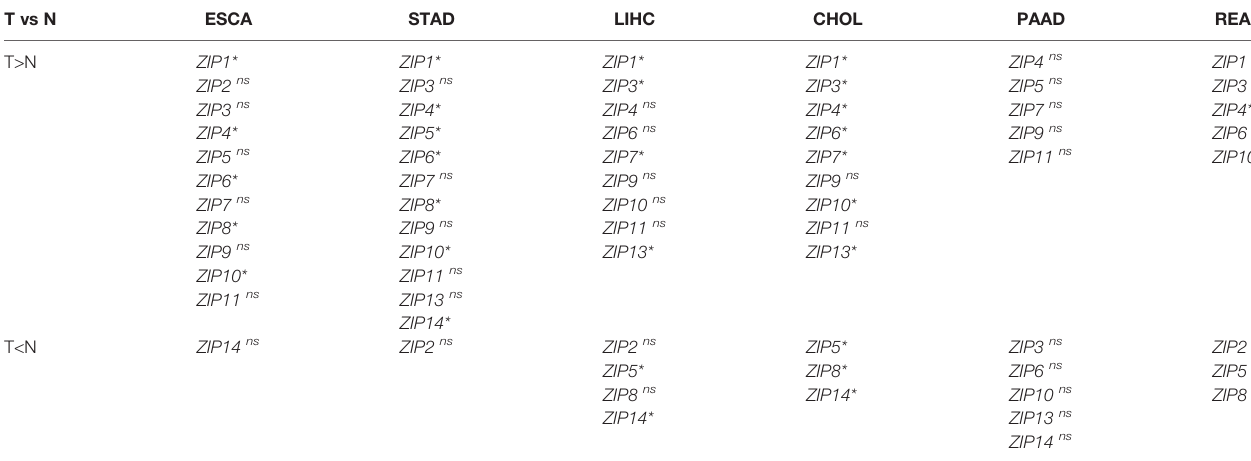
TABLE 3 | Summary of ZIPs transcription levels in human digestive system cancers (T) and healthy controls (N). T vs N ESCA STAD